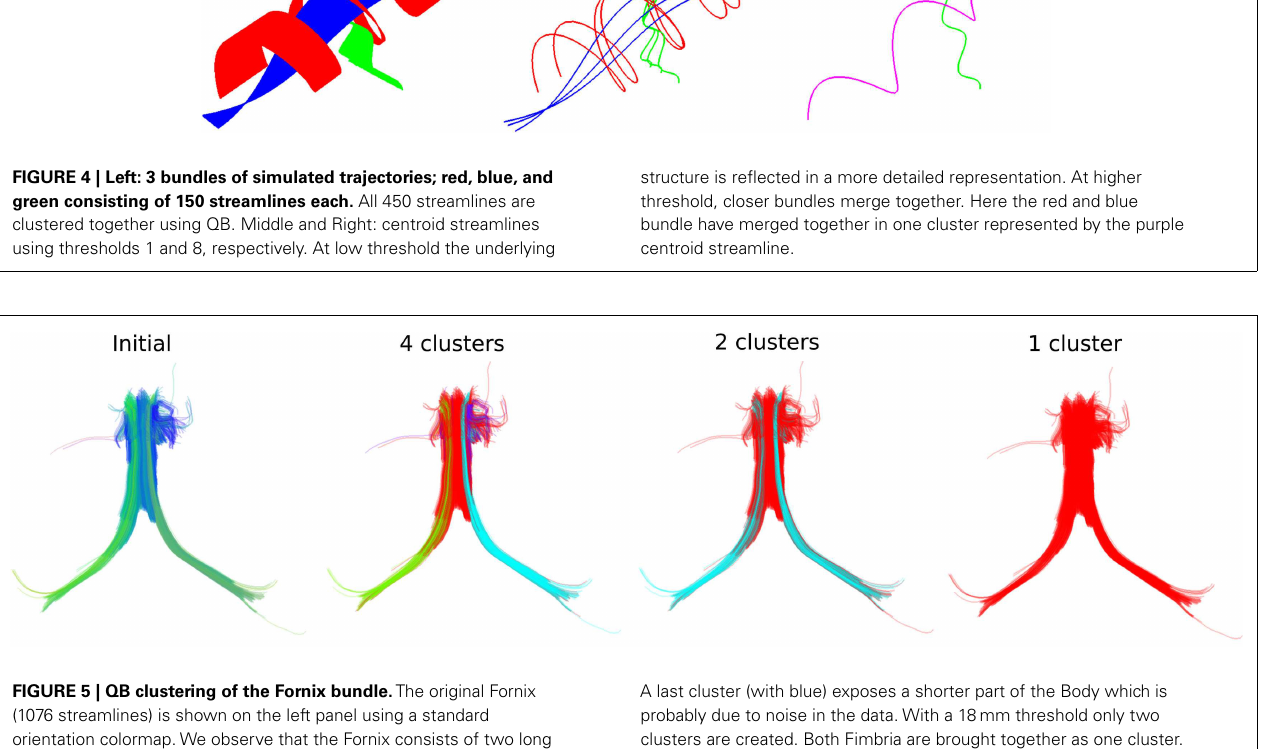
FIGURE 5 | QB clustering of the Fornix bundle. The original Fornix (1076 streamlines) is shown on the left panel using a standard orientation colormap.We observe that the Fornix consists of two long distant legs (left and right Fimbria) and a thicker upper part (Body of Fornix).We show here how QB will be able to distinguish the parts of the Fornix at different resolutions.With a 15mm threshold QB generates 4 clusters shown on the second panel with distinct colors. Here the left and right Fimbria are clearly distinguished from the Body.